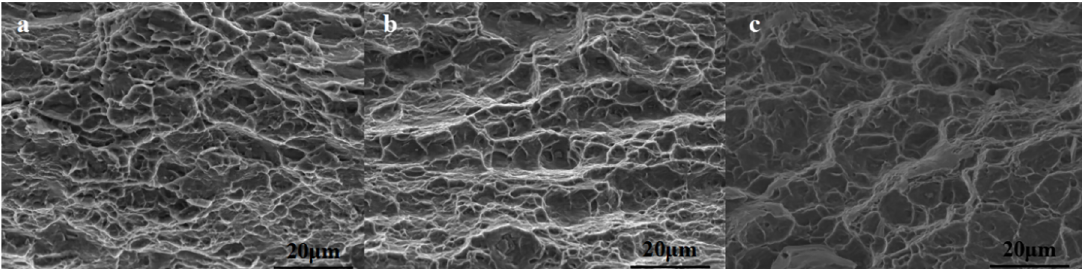
Figure 11. SEM images representing tensile fracture surface of AZ31B Mg alloys from the tensile test specimens annealed at (a) Rolled, (b) 300°C / 1 h and (c) 400°C / 1